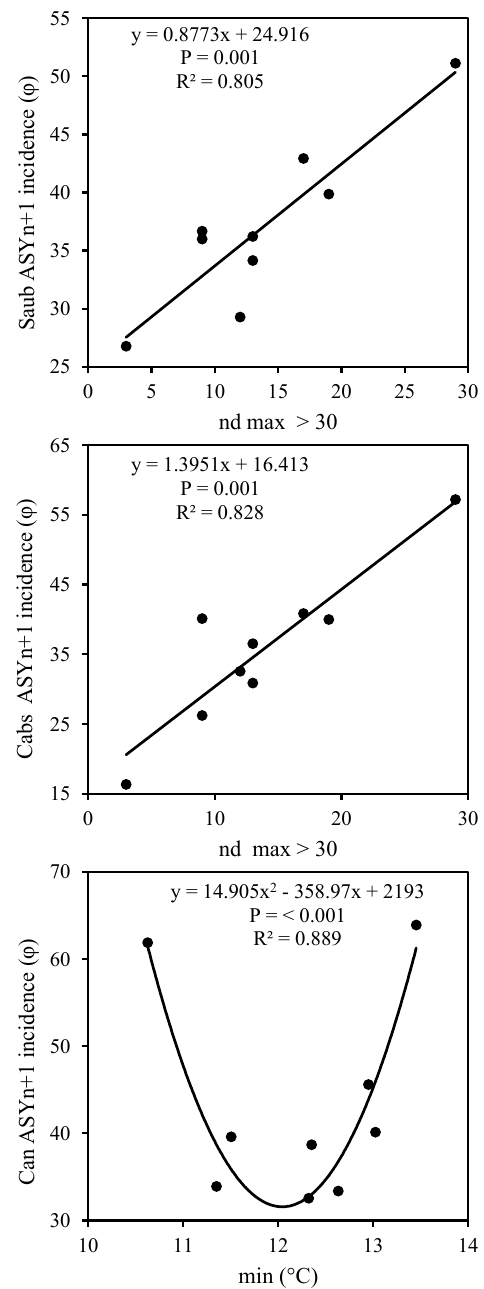
Figure 4. Regressions between arcsin-square root trans- formed (degrees ϕ) annual incidence of Sauvignon blanc (Saub), Cabernet sauvignon (Cabs) and Cannonau (Can) plants showing GLSD foliar symptoms in year n but symp- tomless in year n+1 (ASY n+1) and temperature parameters (nd max > 30 = number of days with maximum tempera- ture above 30 °C; min = average minimum temperature) in the periods May – June of the symptomless